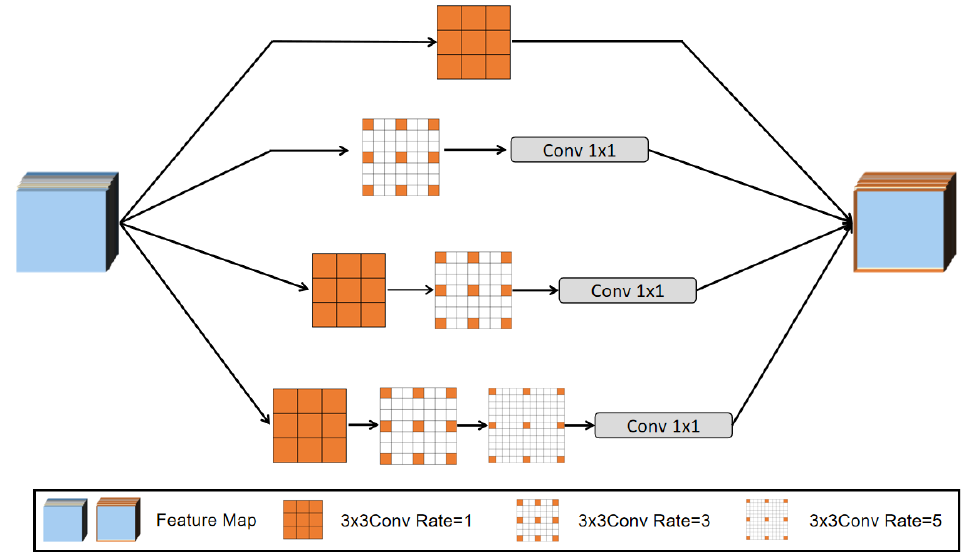
Figure 5. The devised architecture of multiscale cascade block.